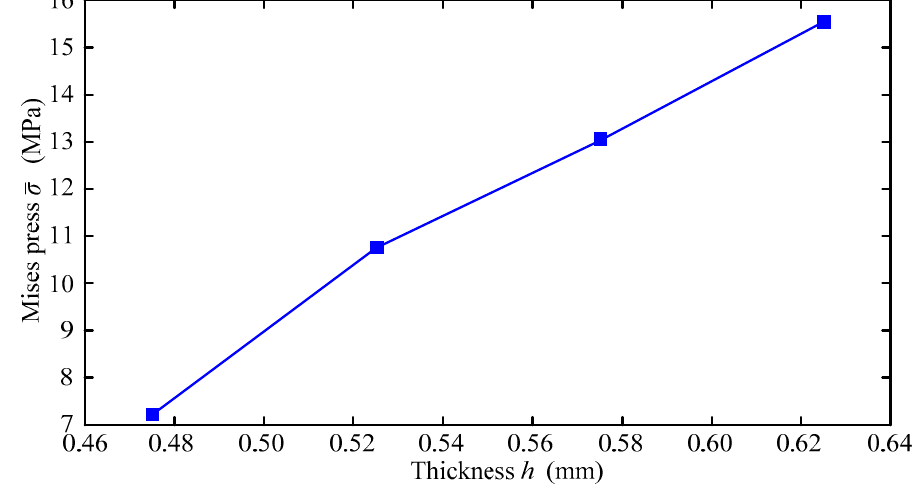
Figure 21. Variation curve of 𝜎 with h .